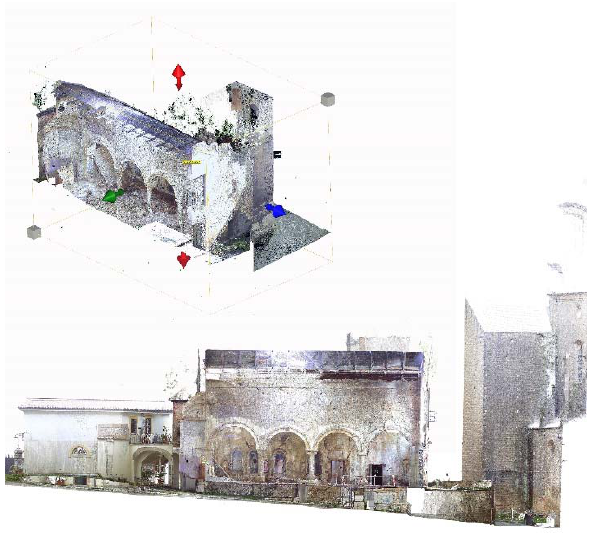
Figure 4. Laser scanning data